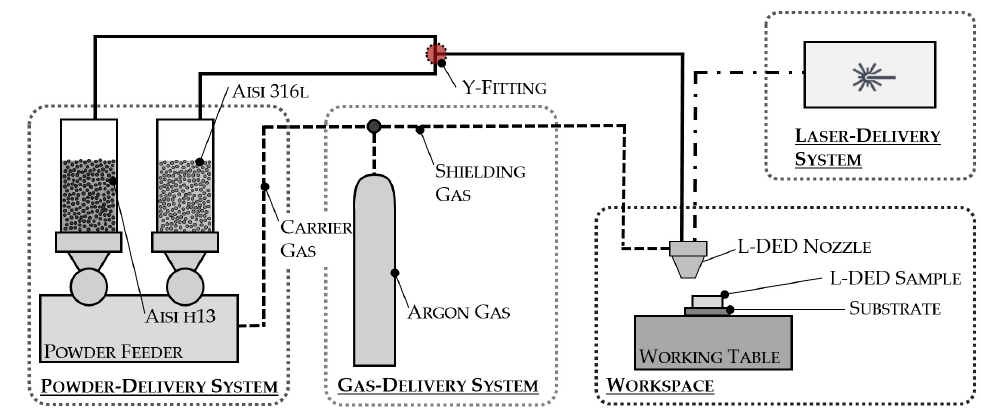
Figure 2. Setup of the L-DED process.